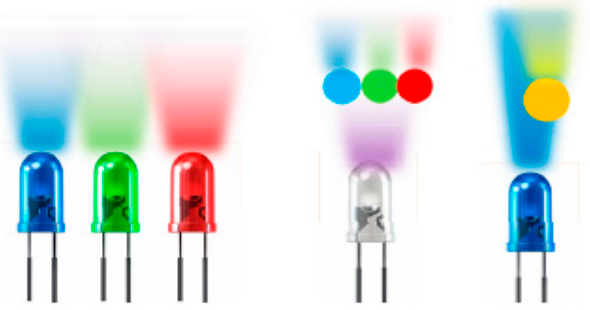
Figure 1. Schematic assembly to obtain white emission in light-emitting diode (LED) technology. In contrast to the RGB approach, a single LED light source can be combined with one or more phosphor materials to obtain white Two strategies can be further distinguished. The first uses a blue LED and converts part of the emitted light to longer wavelengths by means of phosphor material; the obtained white color is from the combination of the residual blue and the down-converted emission. In the second, the white perceived light arises from the fully converted emission from a (near) ultraviolet LED through different phosphors with an overall large emission in the visible spectrum. The latter approach is not widely used because of the higher costs of UV LED pumping and the intrinsic losses of efficiency during the conversion process, but it permits a wider choice in the possible phosphor materials and to achieve improved lighting performances.